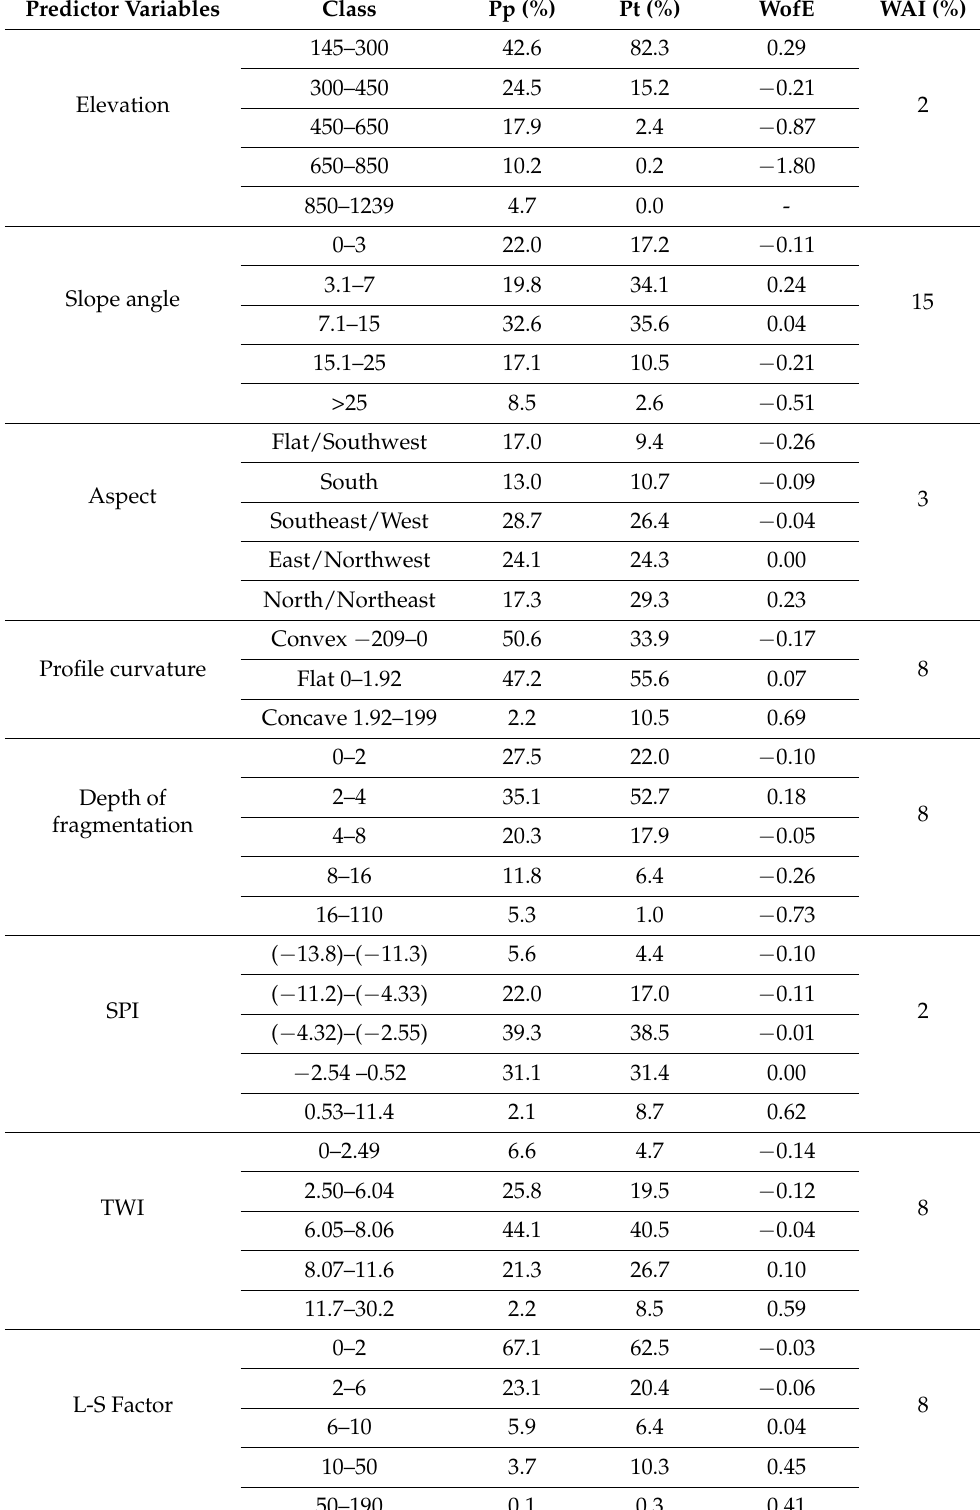
Table 1. Flash flood predictor variables classes with their WofE